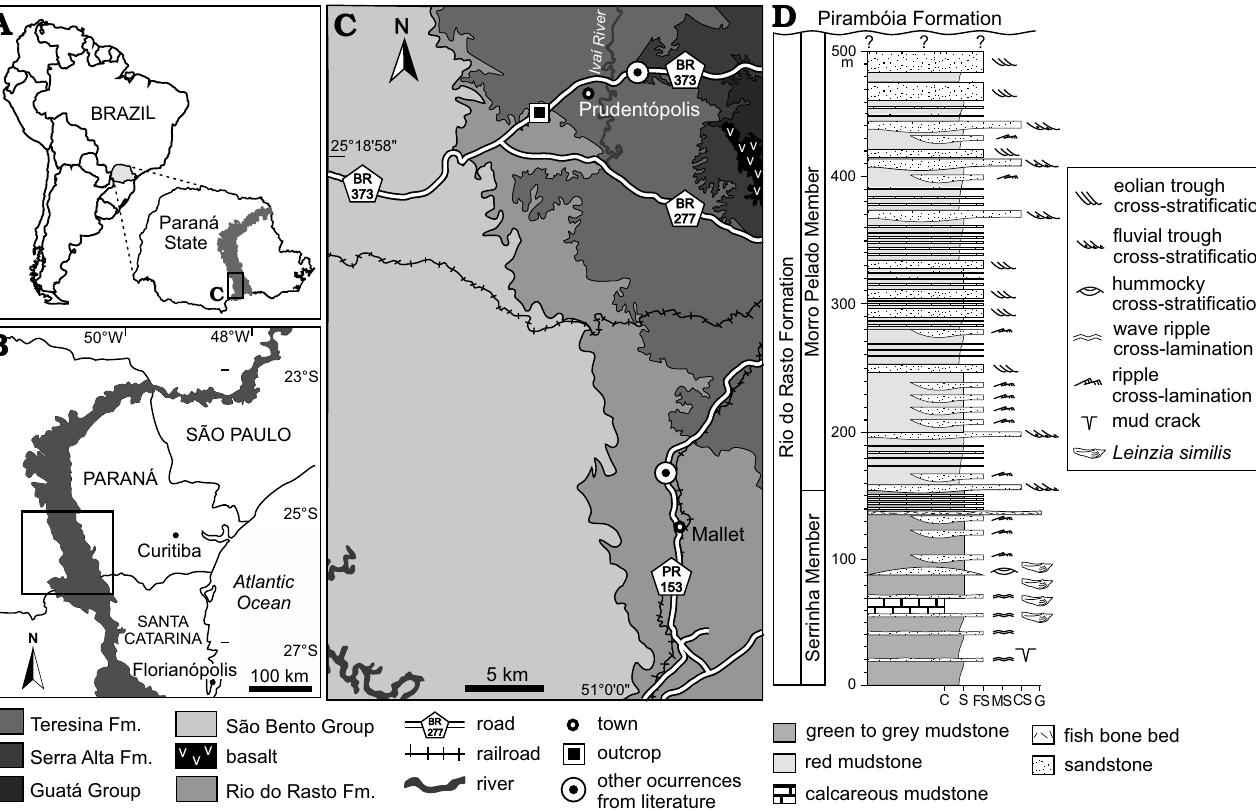
Fig. 2. A . Location of the studied area in the southern part of the Paraná State, south Brazil. The outcrop belt of the Passa Dois Group is in grey. B . Map of the Paraná State, Brazil (frame indicates the southern part where studied area is located) (modified from Rohn and Rösler 2000; Guerrini et al. 2019). C . Geological map showing the main geographic area of occurrence of Leinzia similis (sensu stricto). Cartographic base: Mineropar 2006 (Mapa geológico do Estado do Paraná, 1:250 000). D . Columnar section of the Rio do Rasto Formation; note the constrained stratigraphic distribution of Leinzia similis (sensu stricto) in the Serrinha Member. Abbreviations: C, calcareous mudstone; CS, coarse sandstone; G, gravel; FS, fine sandstone; MS, medium sandstone; S,